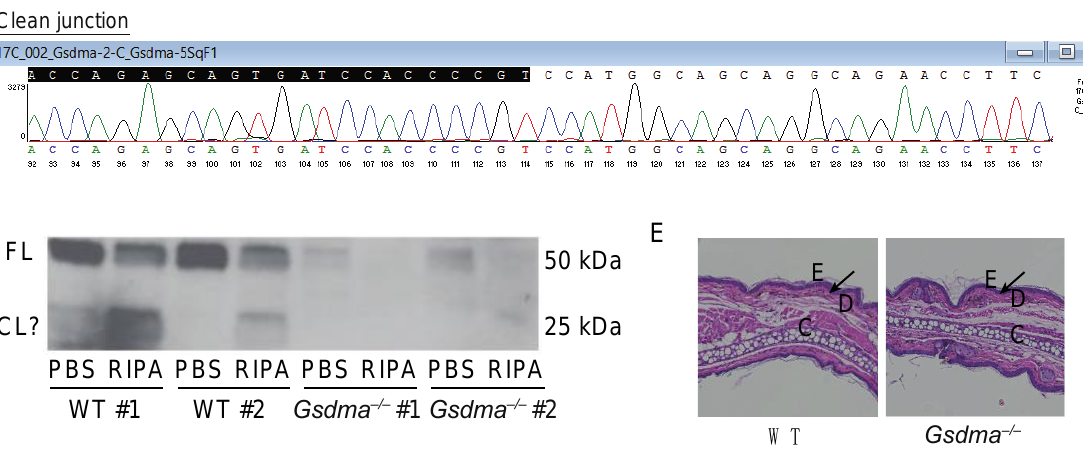
Figure 5. Generation of Gsdma1-Gsdma2-Gsdma3 triple knockout ( Gsdma – / – ) mice. ( A ) Gsdma1 , Gsdma2 , and Gsdma3 are clustered on mouse chromosome 11. CRISPR was used to delete all three genes at the red arrows. ( B ) Gsdma – / – founder mice were validated by PCR using the primer sets (Gsdma-5ScF1 and Gsdma-3ScR1) described in Materials and Methods. ( C ) Gsdma – / – founder mice were verified by Sanger Sequencing, showing a 50kb deletion. ( D ) Western blot of GSDMA using ear tissues of WT and Gsdma – / – mice extracted by PBS and RIPA buffer. FL, full-length GSDMA; CL?, potential cleavage products of GSDMA. ( E ) Histological staining of ear sections from WT and Gsdma – / – mice. E, epidermis; D, dermis; C, cartilage. The epidermal – dermal junctions are indicated by the black arrows.